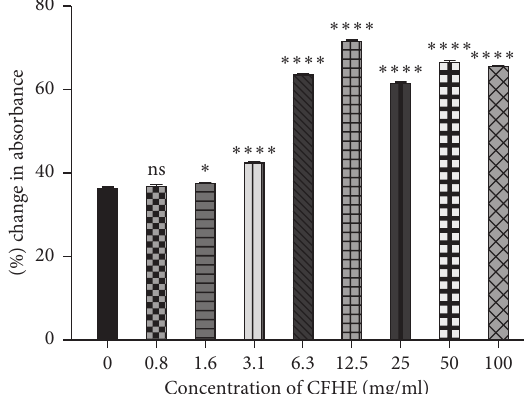
Figure 2: The percentage change in absorbances obtained for the different concentrations of the CFHE in an in vitro platelet ag- gregation test. Values plotted are Mean ± SEM ( n � 3). Ns p > 0 . 05, ∗ p ≤ 0 . 05, ∗∗∗∗ p ≤ 0 . 0001, treatments compared to control group (one-way ANOVA followed by Dunnett’s multiple comparisons